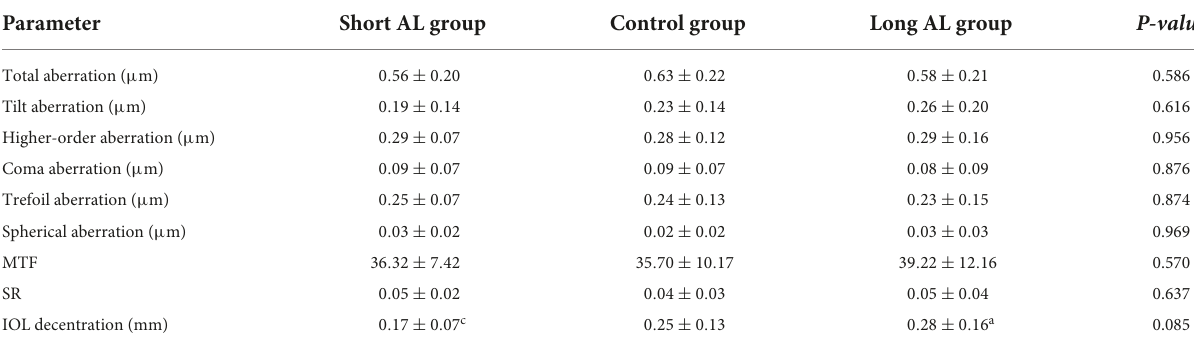
TABLE 3 Aberrations, MTF, SR and IOL decentration using OPD scan-III. Parameter Short AL group Control group Long AL